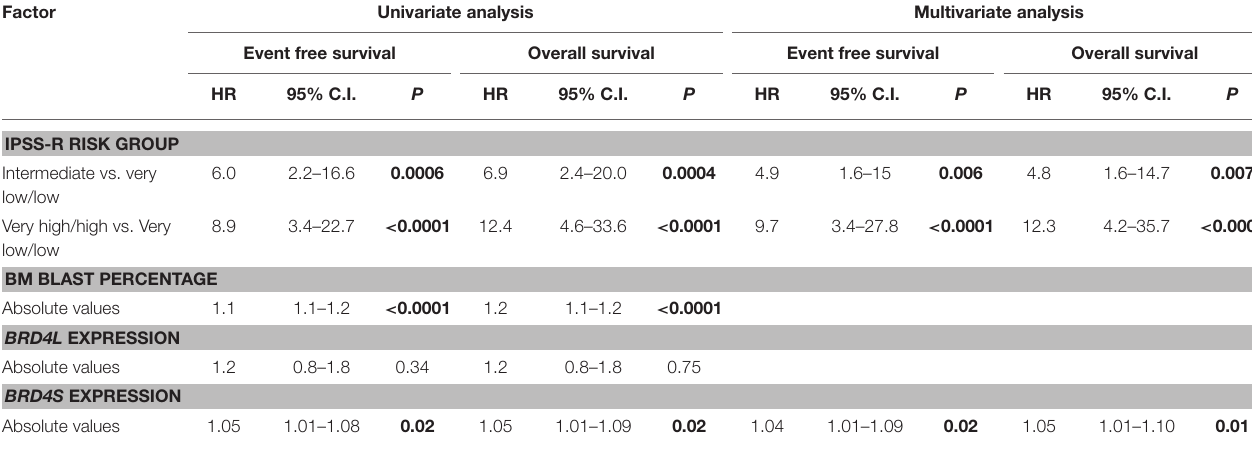
TABLE 2 | Univariate and multivariate analysis for event-free survival and overall survival of MDS patients. Factor Univariate